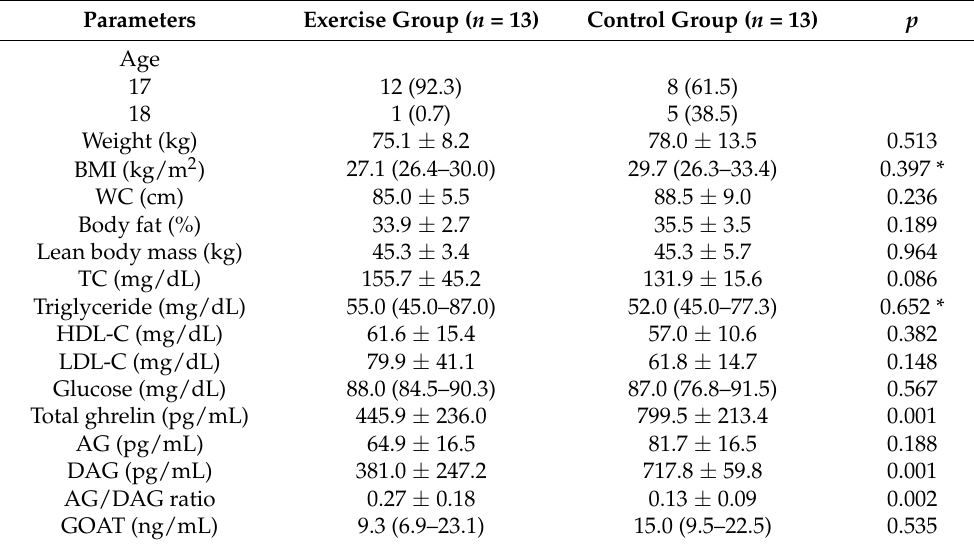
Table 1. Baseline characteristics and metabolic parameters of the